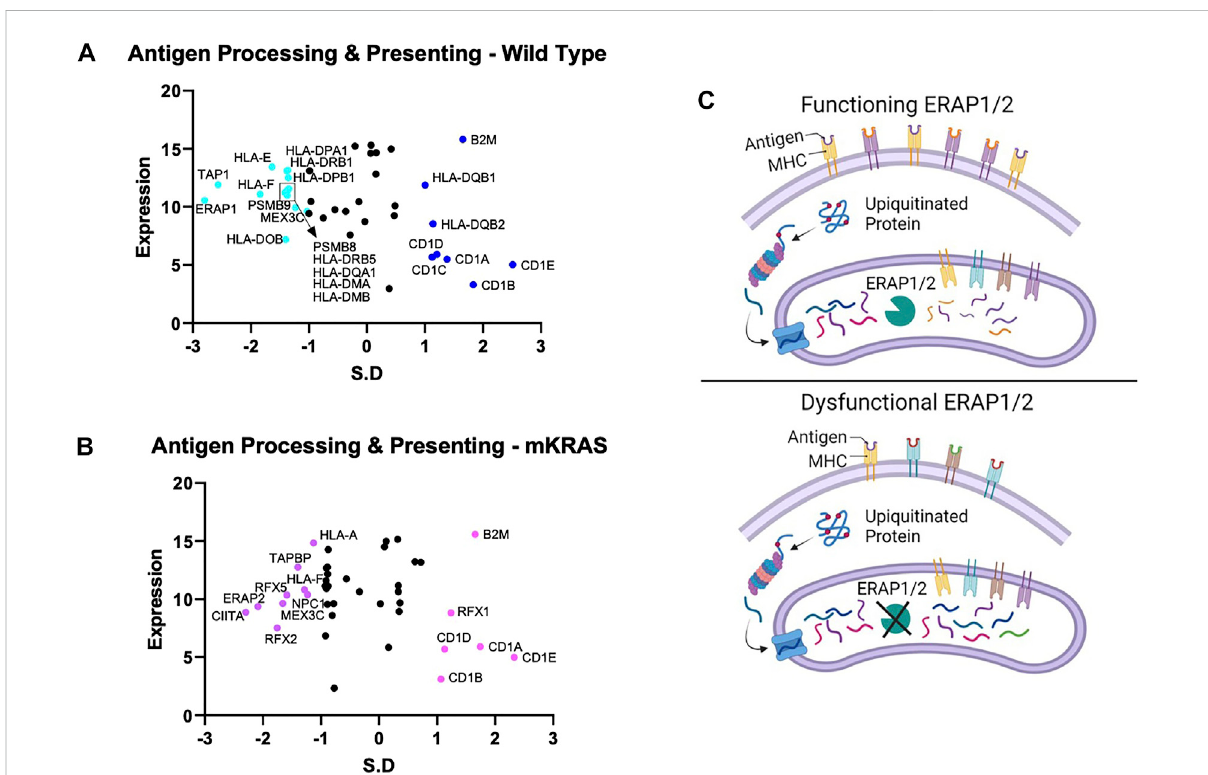
FIGURE 3 Gene conservation in antigen presentation genes. Gene conservation score, measured as the standard residual from the regression line (SR) graphed against genes expression levels (Log2) for wild-type (no identi fi able driver mutations) (WT) (A) and mutant KRAS (mKRAS) (B) . Conserved genes(SR ≤ -1.0)andover-mutatedgenes(SR ≥ 1.0)arecoloredandlabelledwithtext.ERAP1andERAP2sculptthepeptidepoolpriortopresentation by MHC-I proteins. Dysfunctional ERAP alters the peptides presented (C) . Standardized residual (SR). Created with